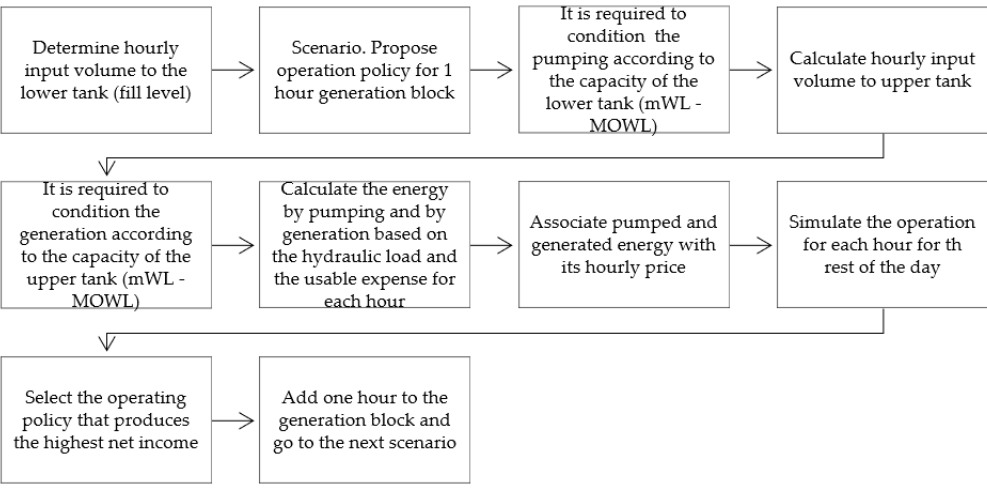
Figure 10. Optimization methodology for the operation policy .